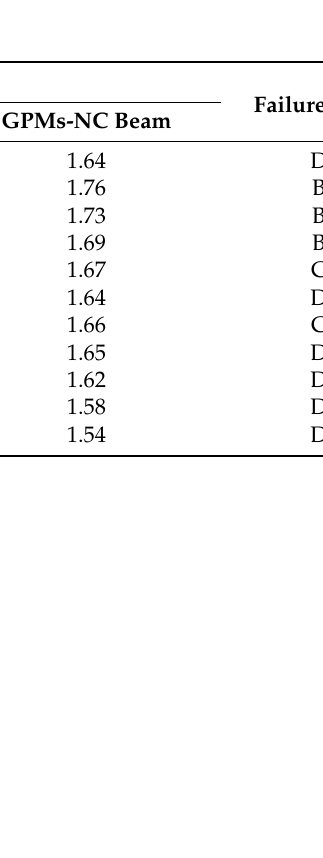
Figure 6. Failure mode of GPM specimens under 10% of H 2 SO 4 exposure.